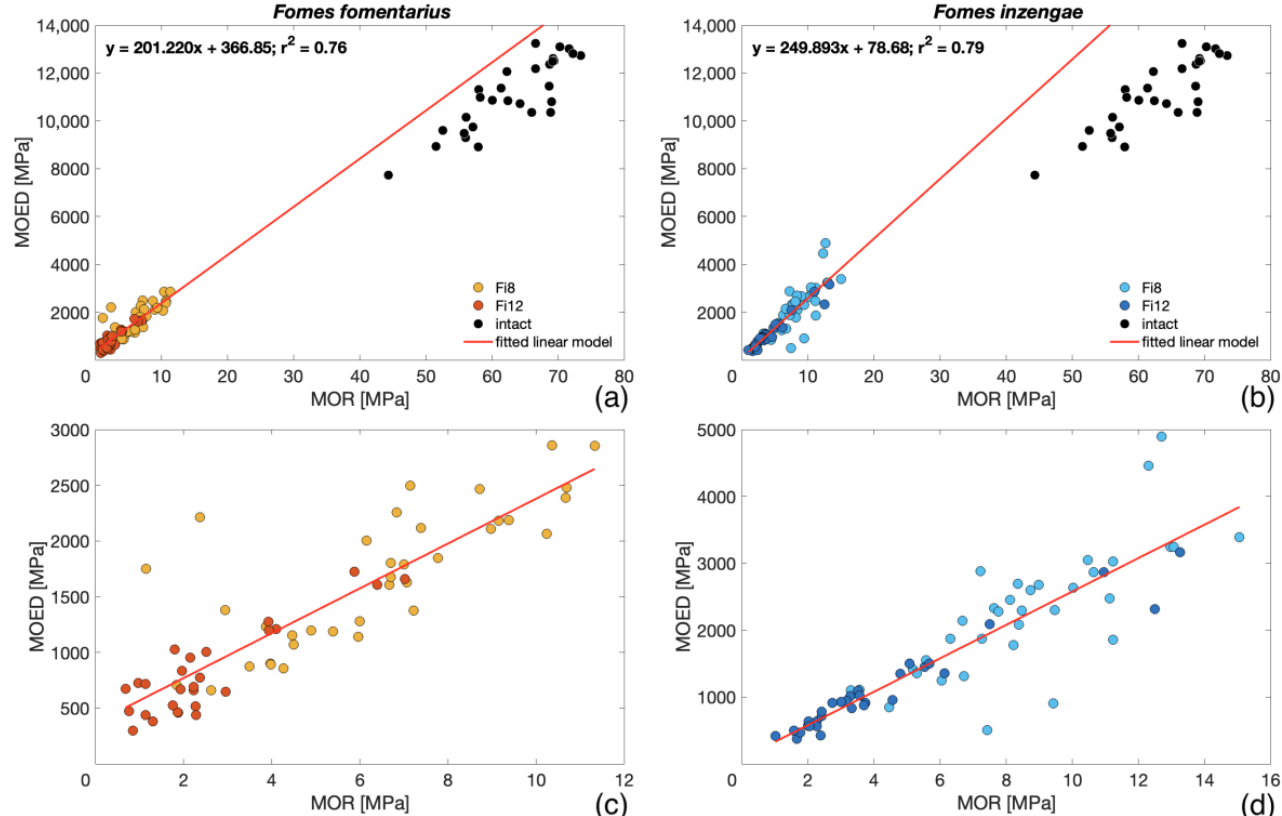
Figure 6. Linear relationship between MOR and MOED for bending specimens exposed to F. fomentarius ( a ) and F. inzengae ( b ) cultures and a closer representation without data from intact samples ( c , d ).